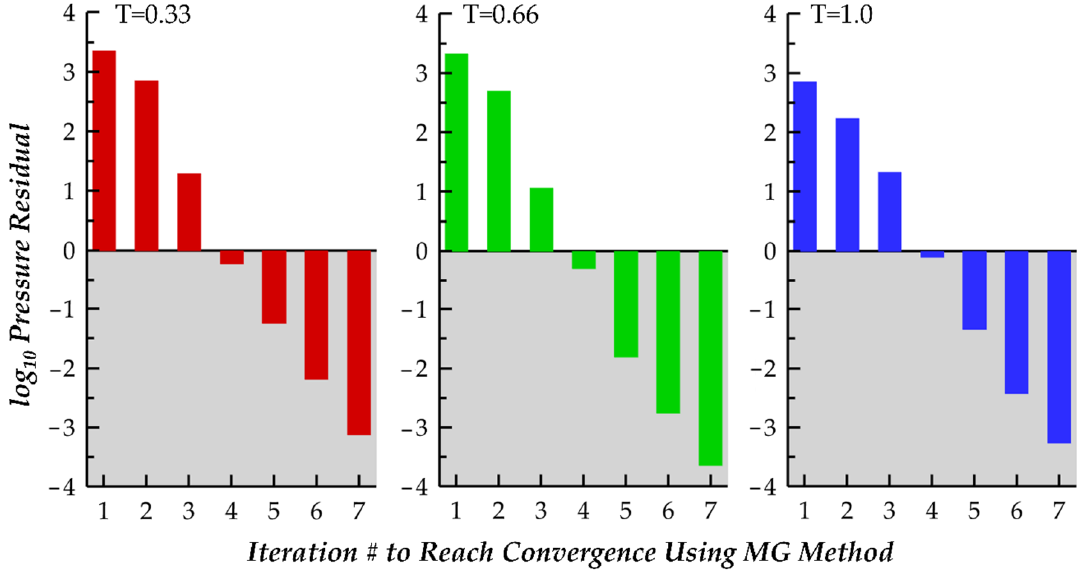
Figure 5. Illustration of Poisson equation pressure convergence for 3 time steps during a cycle of motion: T = 0.33 (320th time step), T = 0.66 (640th time step), and T = 1.0 (960th time step).